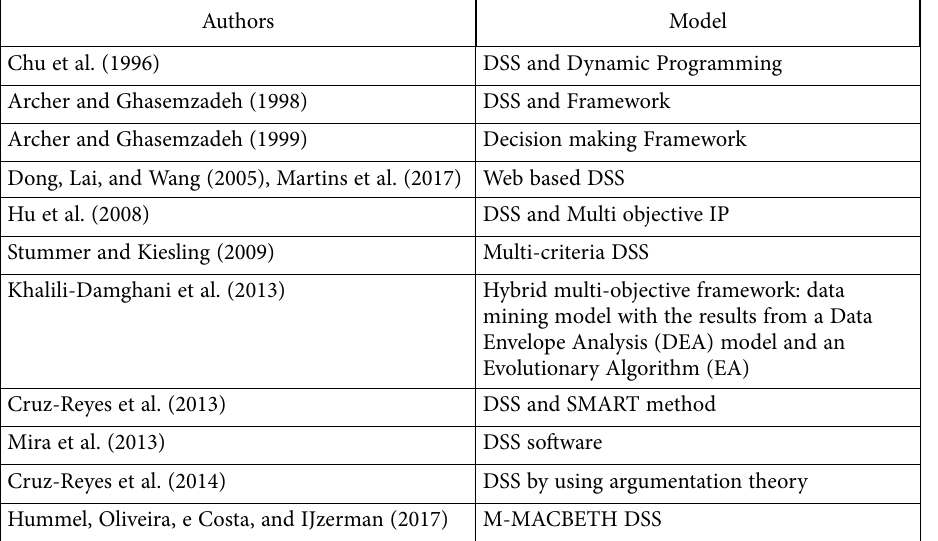
Table 11. Using framework and DSS in PPS